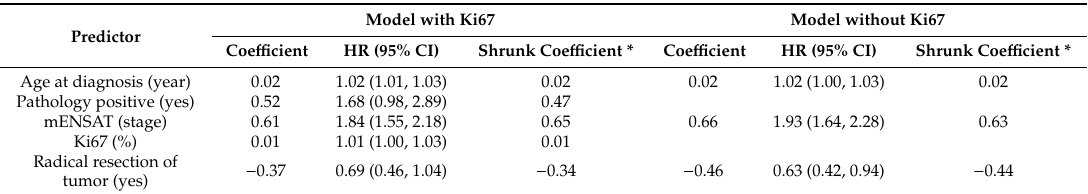
Table 2. Initial and internally validated coe ffi cients of the prediction model for ACC-specific mortality.